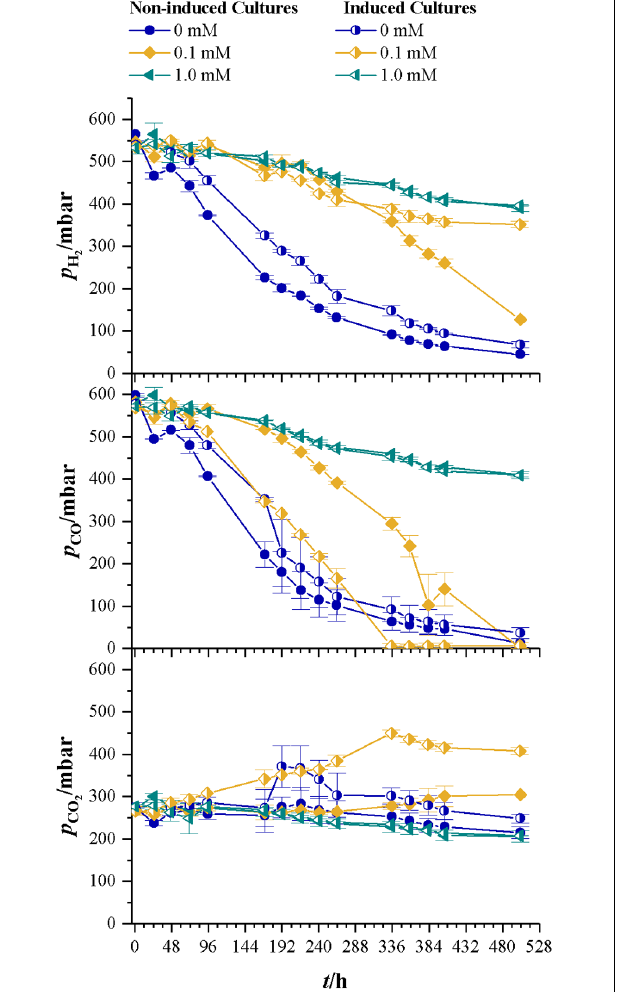
FIGURE 7 | Development of partial pressures of H 2 , CO, and CO 2 for non-induced C. ljungdahlii (full symbols) vs. the induced strain (half-filled symbols) at different cyanide concentrations with syngas as carbon and energy source. Cyanide concentrations are 0 (blue dots), 0.1 (yellow diamonds), and 1.0 mM (petrol tilted triangles). Since no growth occurred in the bottles with 1.0 mM cyanide, those values represent the pressure